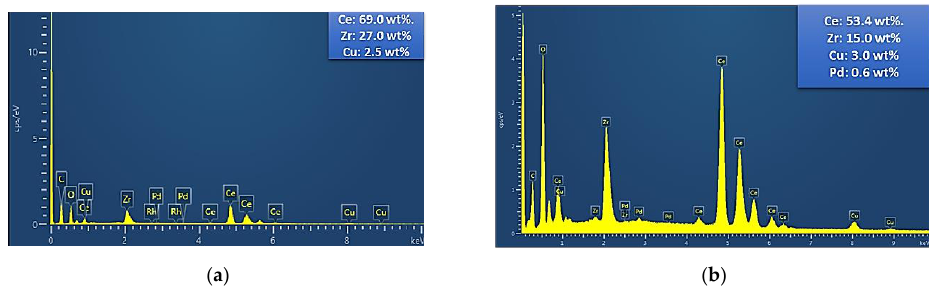
Figure 10. Mapping analysis of the catalysts: ( a ) PROM2; ( b ) PROM5.